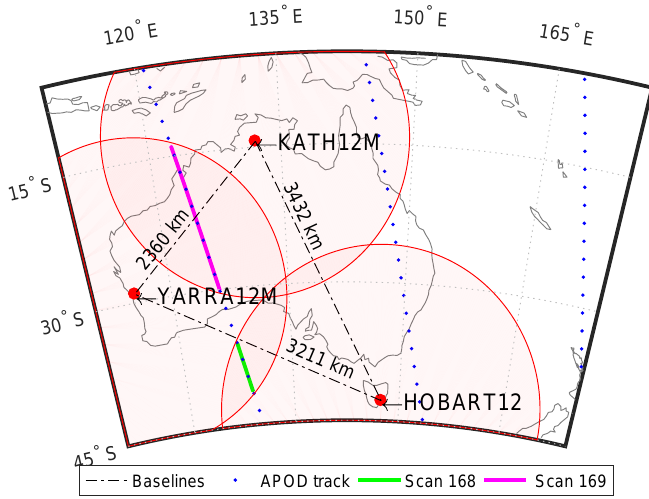
Figure 2. The AuScope Very Long Baseline Interferometry (VLBI) array consists of the three antennas at Hobart (Hb, Tasmania), Katherine (Ke, Northern Territory), and Yarragadee (Yg, Western Australia) indicated by filled red dots. The continental wide baselines (dotdashed lines) with lengths from 2360 to 3432 km only allow for limited mutual visibilities of the APOD satellite which orbits the Earth on an altitude of only ∼ 470 km. Projected fields of view of individual sites are displayed by shaded red circles assuming local cut-off elevation angles of 5 ◦ . The APOD ground tracks during Experiment a332 (27 November 2016; see Table 1) are represented by blue dots indicating successive satellite positions in a 30 s interval. The projected APOD positions in Scans 168 (10:41:04 to 10:42:30 UTC) and 169 (10:44:02 to 10:48:18 UTC) of Experiment 332a are indicated by lines in green and magenta,